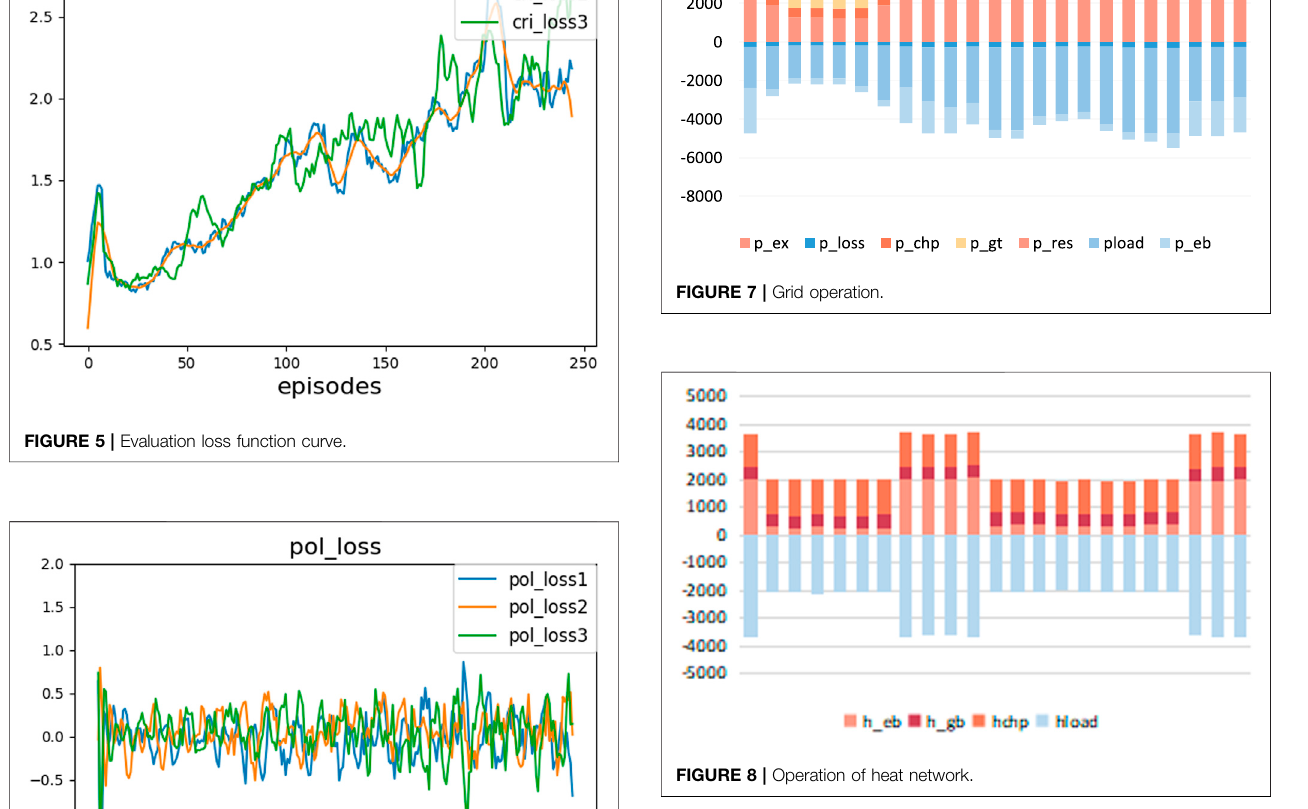
FIGURE 8 | Operation of heat network.